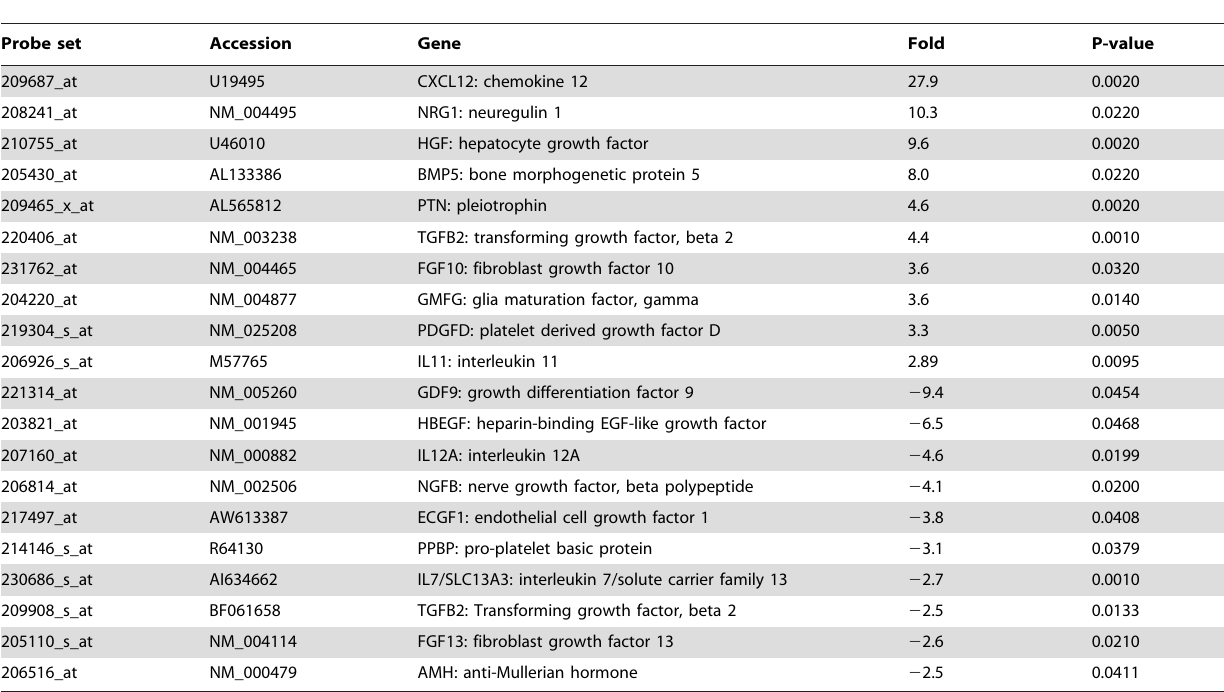
Table 2. Significant differential expression of stromal growth factor genes in response to 3D epithelial cultures.